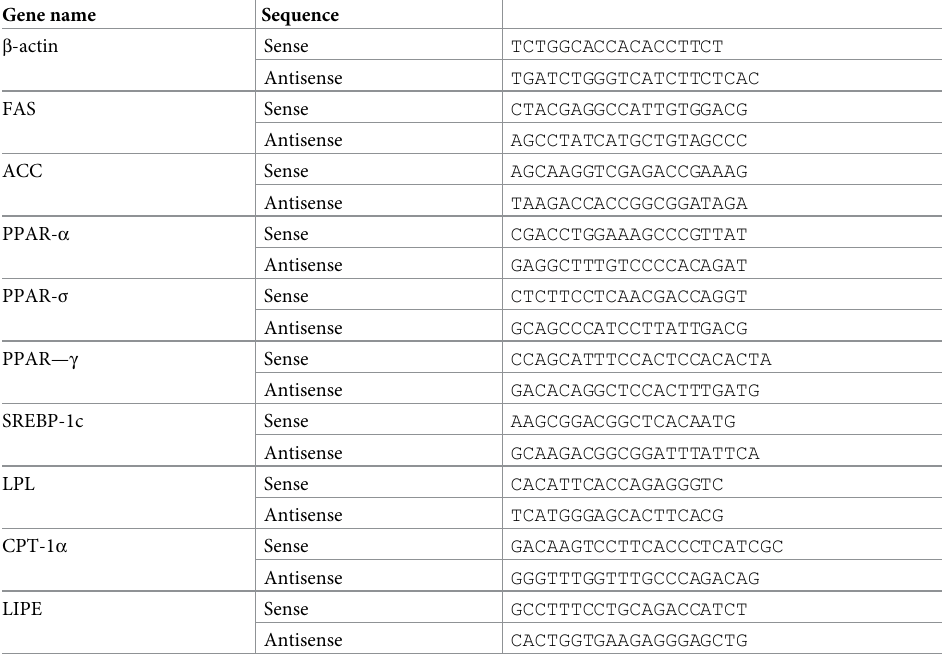
Table 2. Primer lists used for real time PCR